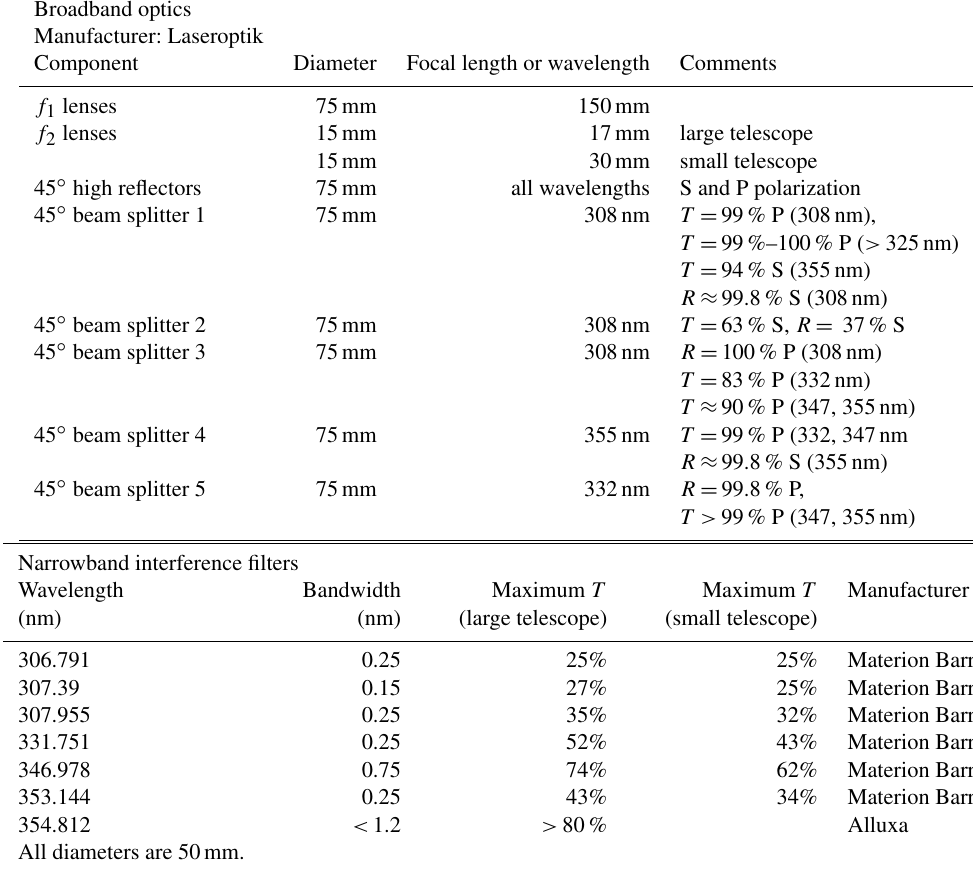
Table 3. Specifications of the polychromator